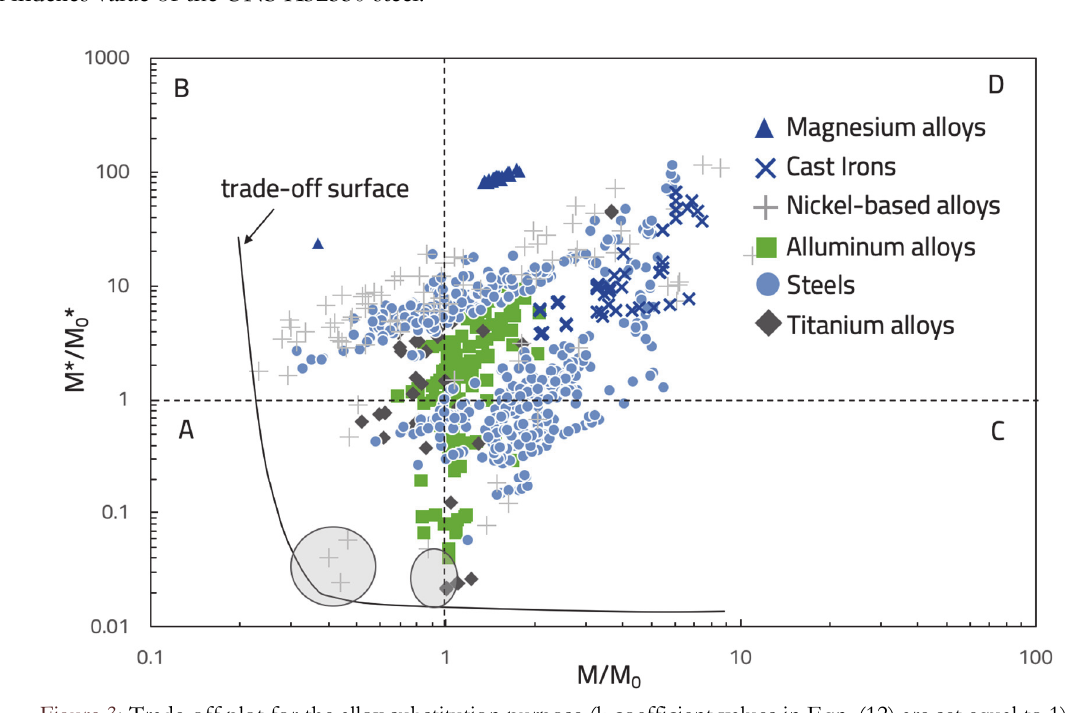
Figure 3: Trade-off plot for the alloy substitution purpose (k coefficient values in Eqn. (12) are set equal to 1). Each symbol, in Fig. 3, represents a different material. Those which have the characteristic that no other solution exists with lower values of both the performance metrics are said to be non-dominated solutions; the line on which they lie is called optimal trade-off